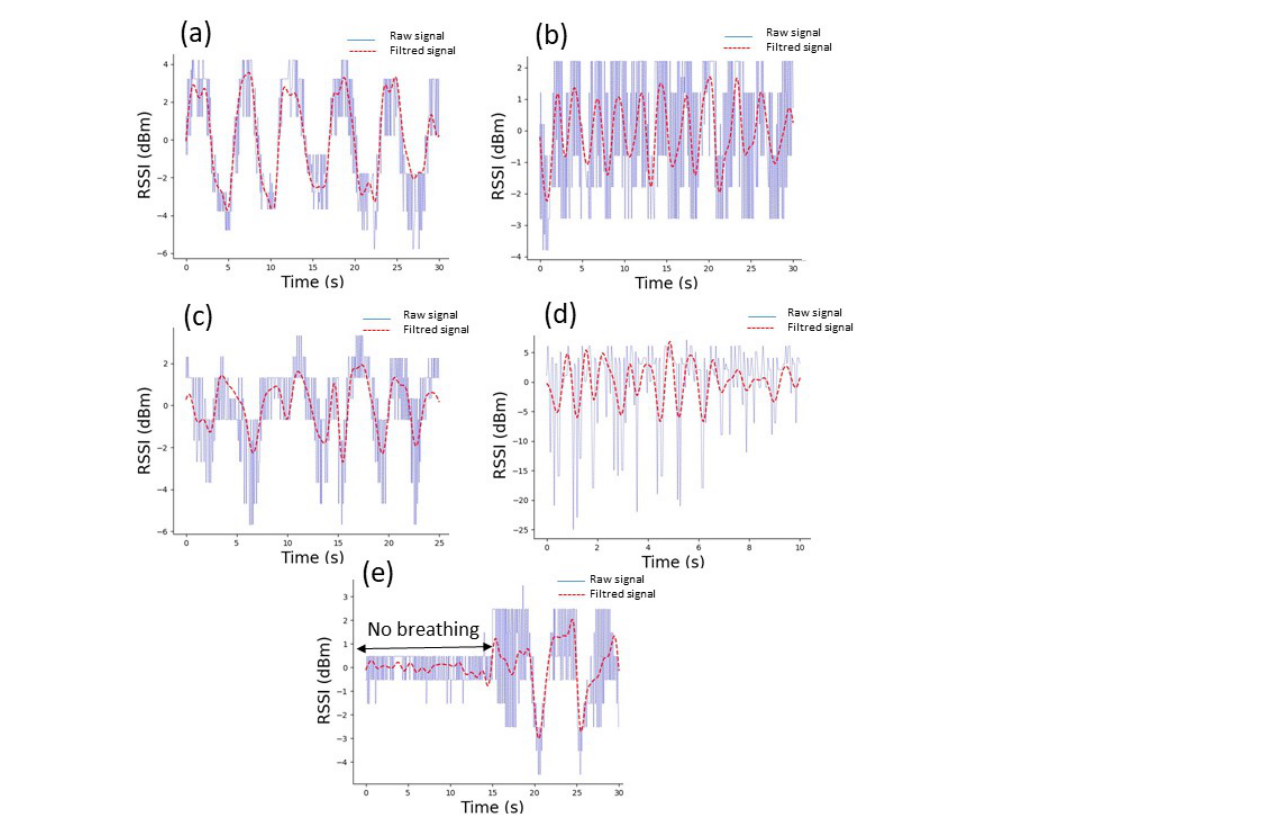
Figure 10. Breathing signal patterns obtained from the RSSI measurements (blue) and the corresponding filtered signals (red) for slow ( a ), shallow ( b ), irregular ( c ), fast ( d ) and a combination of no and deep long breathing ( e ).